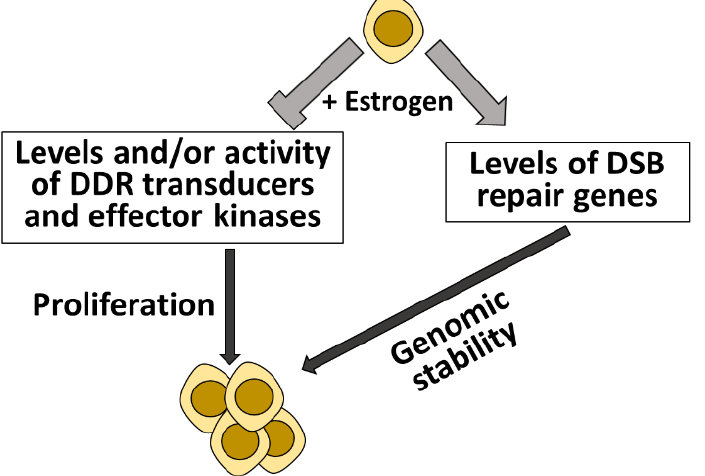
Figure 2. Estrogen regulates the level and activity of numerous DDR genes to allow cell proliferation and to ensure genomic stability. Addition of estrogen to cells results in reduced amounts ATM and Chk1. It will also reduce the activity of ATR and Chk1. These three kinases act upstream to the DDR, and their activity restrains cell proliferation. Thus, reduction in their level/amount will trigger cell proliferation. On the other hand, estrogen addition results in augmentation of genes directly involves in DSB repair, which will improve DSB repair and safeguard genomic stability of the proliferating